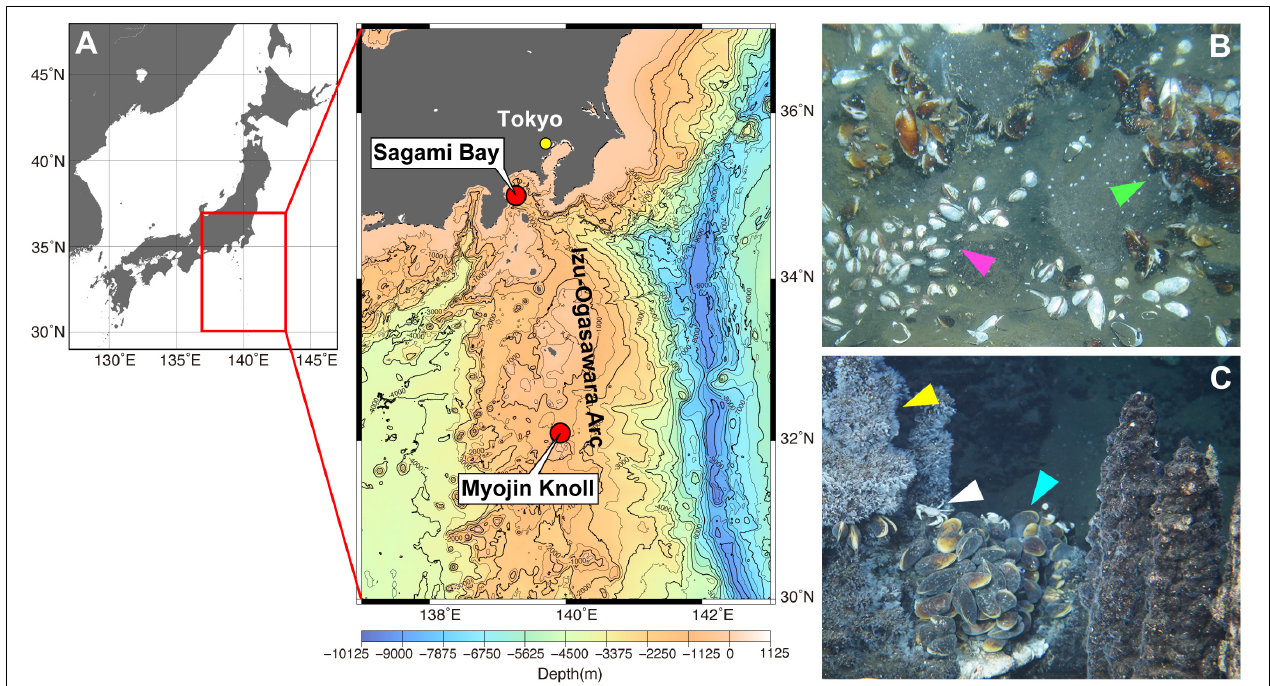
FIGURE 1 | Sampling sites in this study. (A) Maps of the sampling sites in this study. The red box in the left panel [generated using Ocean Data View (https://odv.awi.de)] corresponds to the area in the right panel [generated using Generic Mapping Tools (Wessel et al., 2019) by Japan Oceanographic Data Center, with 500 m mesh water depth data (J-EGG500)]. (B) Phreagena clams and Bathymodiolus japonicus in Sagami Bay. The clams burrow into the sediment (magenta arrowhead), while the mussels attach to rocks on the bottom (light green arrowhead). (C) Bathymodiolus septemdierum at Myojin Knoll. The mussels form a